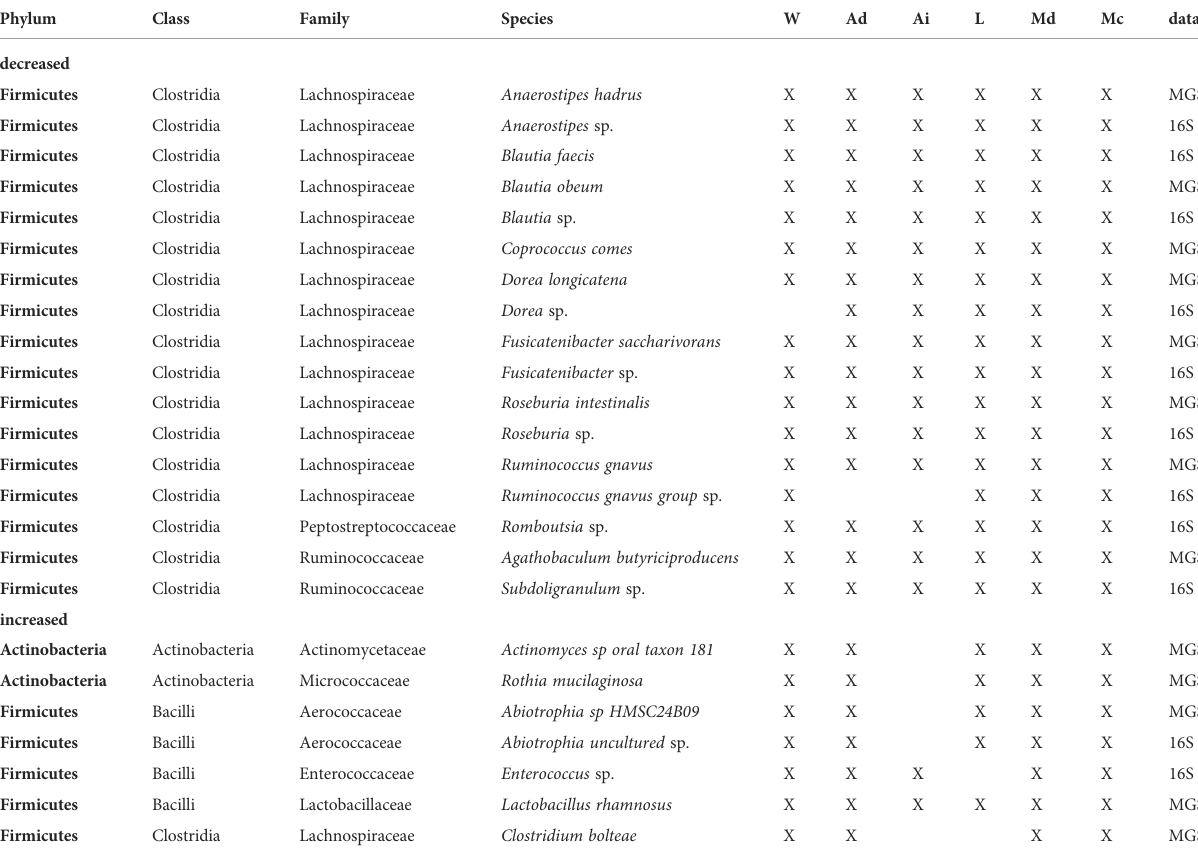
TABLE 5 Taxa identi fi ed by 4 or more different methods as being differentially abundant based on antibiotic use in the 15 days before sampling identi fi ed in 16S and MGS